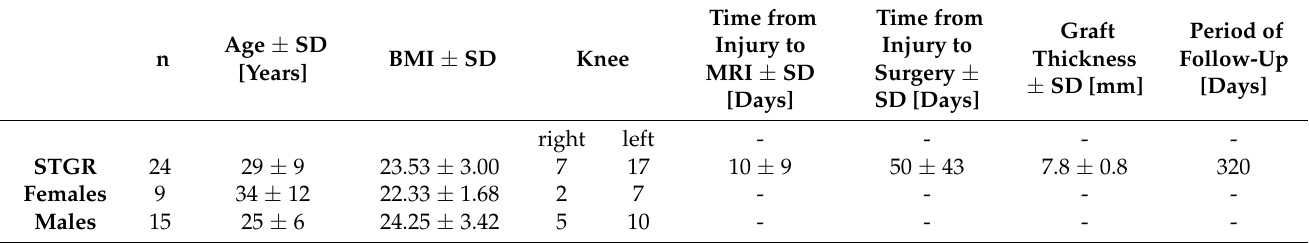
Table 1. Demographic